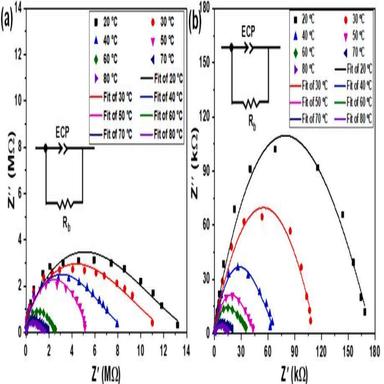
Nyquist plots (Z″ vs. Z′) for (a) pure PVA and (b) PVA/Gr-7 wt% NQNs at temperatures ranging from 20 ◦C to 80 ◦C. The inset in each panel shows the equivalent circuit model used for fitting, comprising Rb and CPE.